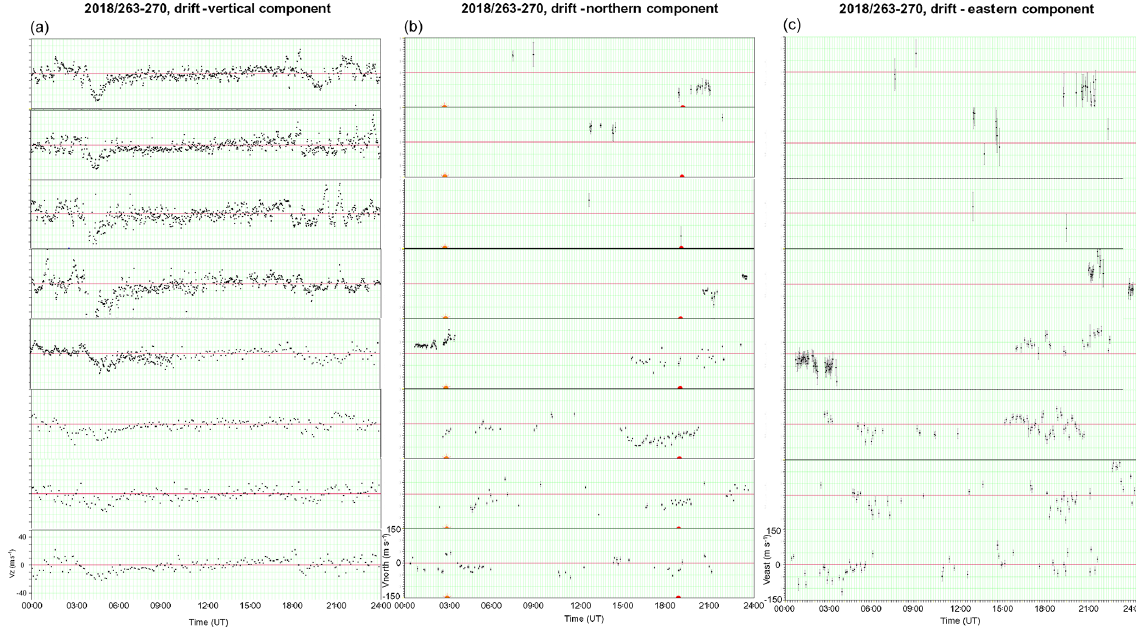
Figure 14. Components of ionospheric plasma drift obtained by Digisonde DPS-4D during the studied event on 20 September (top panel) to 27 September (bottom panel) – (a) vertical component; (b) northern component; (c) eastern component presented in a standard DPS-4D